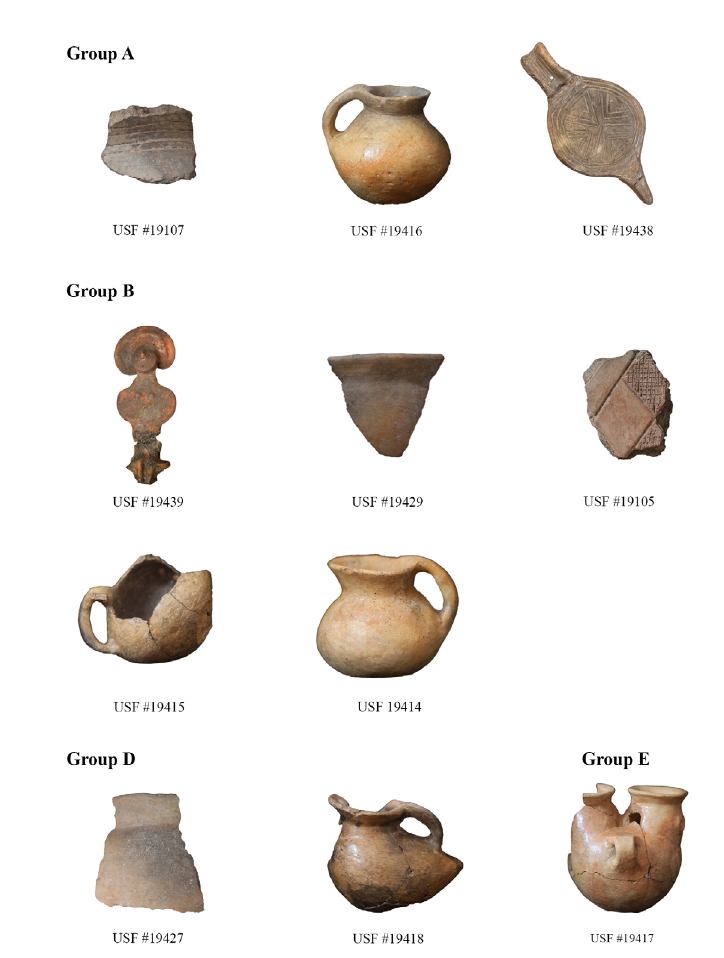
Figure 8. Selection of sherd and pottery examples from the Tarxien Cemetery phase and group assignments based on